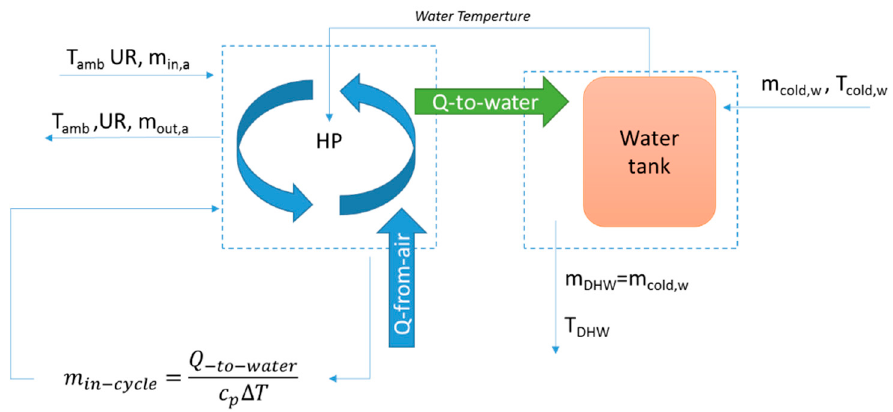
Figure 3. HPWH simulation model.